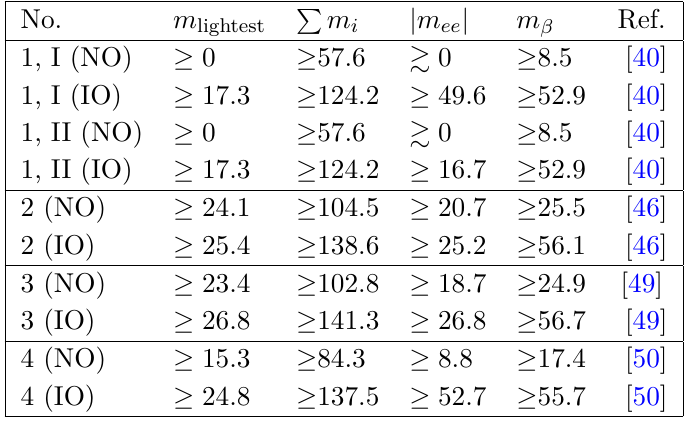
Table 3 . Overview of lower bounds on various observables derived from the new mass sum rules discussed in this paper. Masses are given in meV. For more details, see main